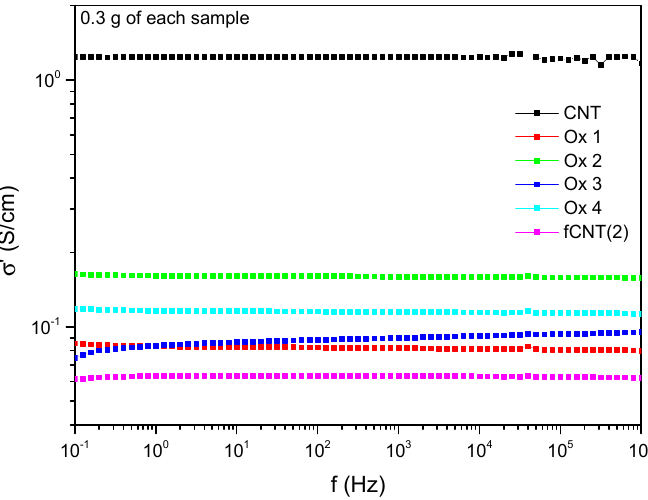
Figure 9. Intrinsic dielectric conductivity of modified and unmodified CNTs. Table 2. Further modification of oxidation method 2 (Ox 2).